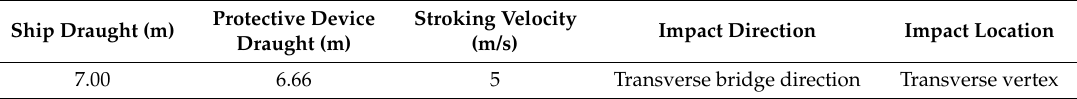
Table 7. Boundary conditions of the ship’s collision.